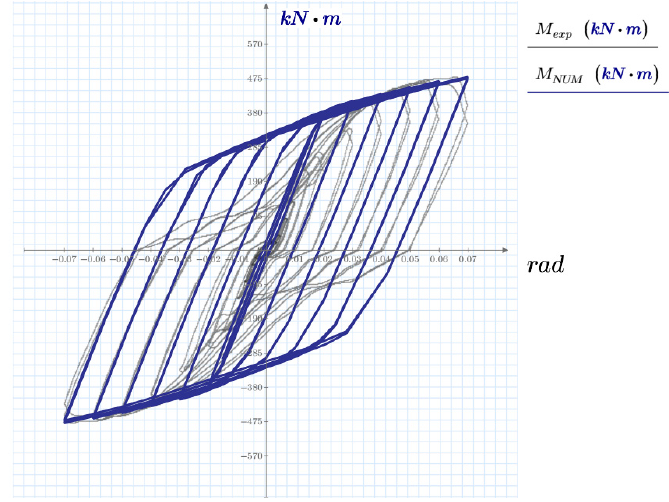
Figure 9. Experimental and numerical moment-rotation curves.